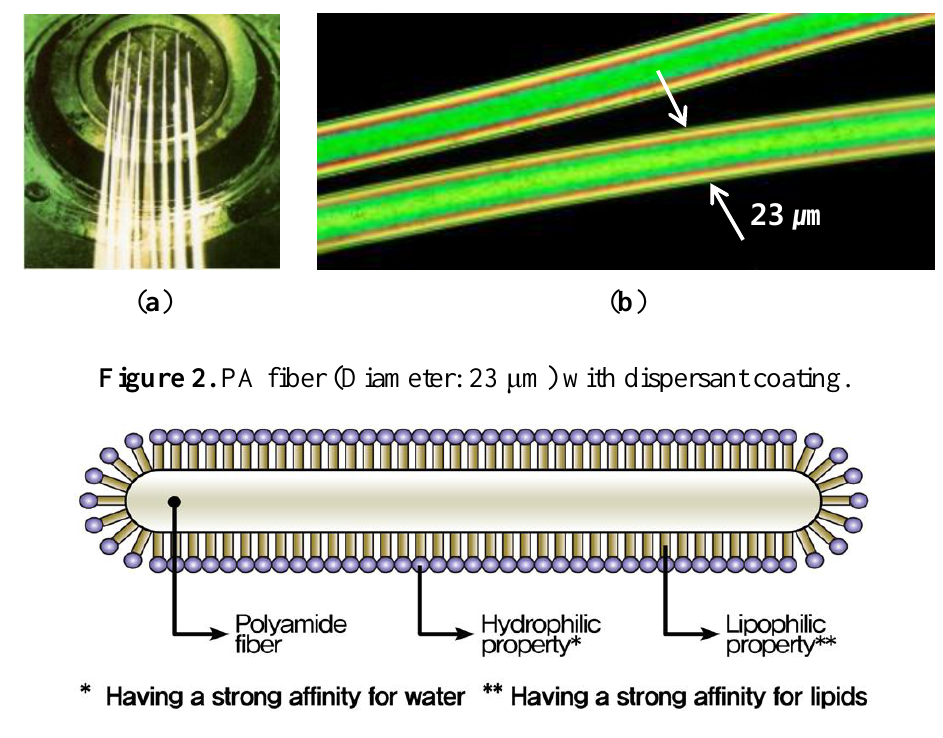
Figure 1. Picture of micro polyamide fibers. ( a ) Single polyamide fiber production; ( b ) magnification of single polyamide fiber.